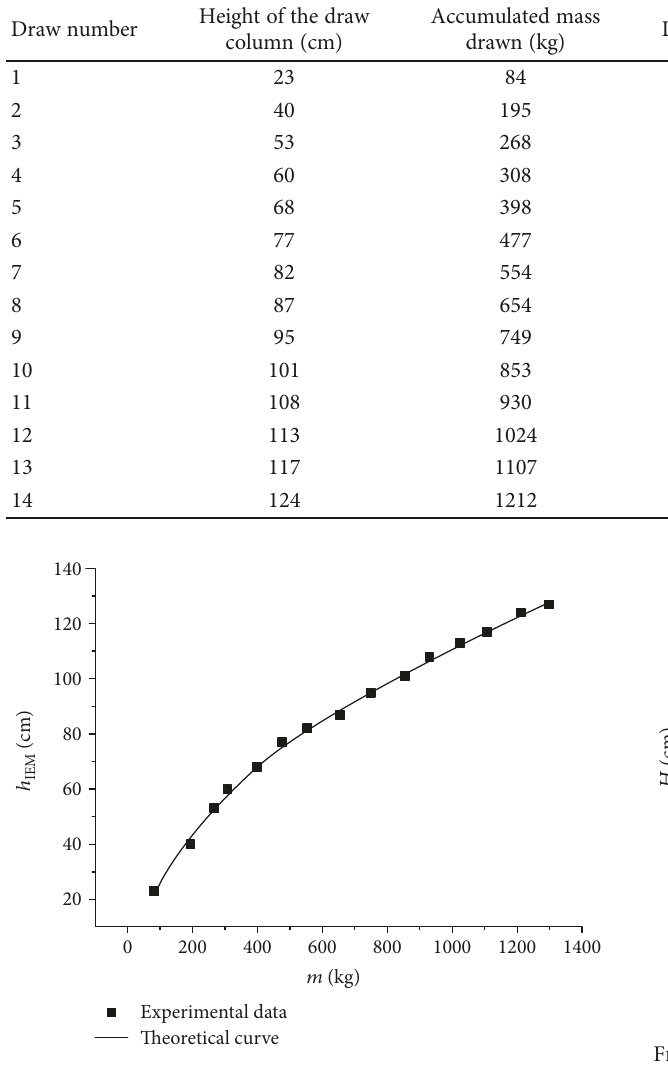
Figure 8: Comparison between the theoretical curve and experimental data. Table 7: Fitting results of the coe ffi cient in equation